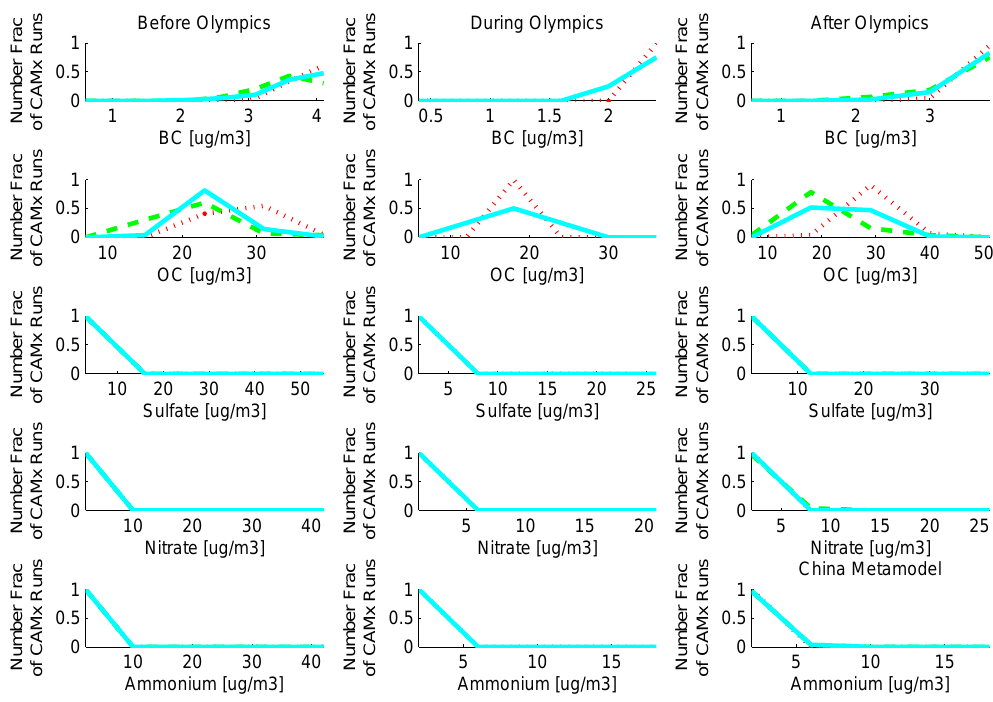
Fig. 6. PDFs of the number of CAMx runs matching the entire set of concentrations for the Beijing site. The x-axis is the concentration of each respective species (BC, OC, sulfate, nitrate, and ammonium), during each time period considered at the Beijing site (BO, DO, and AO), while the y-axis is the normalized number count in terms of the number of CAMx runs matching all 5 species (Table 8). The different colors refer to the different meteorologies for each metamodel.